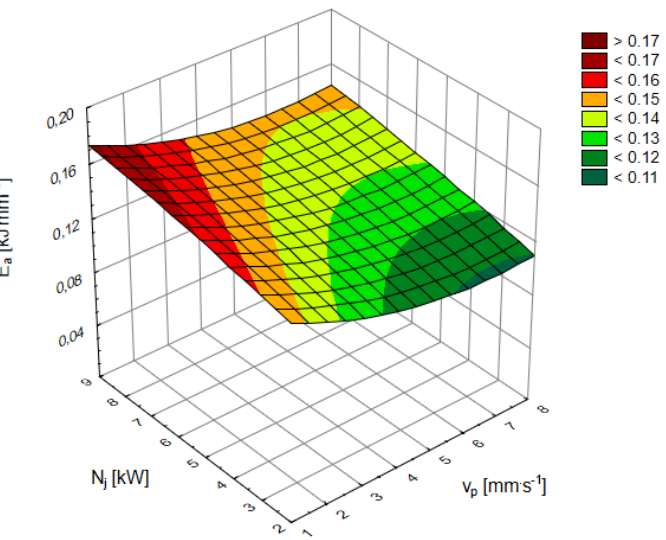
Figure 15. Influence of jet power and traverse speed on the energy consumption of granite with abrasive waterjet: feed speed v p = 3 mm·s − 1 , flow of abrasive 𝑚(cid:4662) (cid:3028) = 6.7 g·s − 1 .